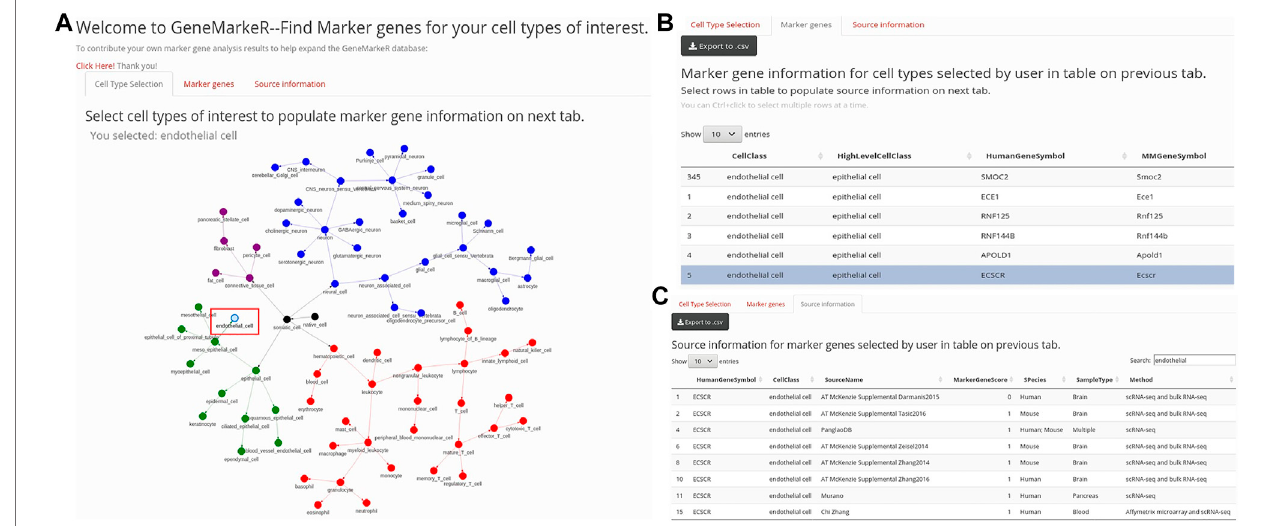
FIGURE 1 | GeneMarkeR user interface. (A) “ Cell Type Selection ” tab enables selection of cell types from a drop-down menu (not shown) and a hierarchical cell network(abbreviatednetworkshownhere).Uponselectionofcelltypes,the “ Markergenes ” tabispopulated. (B) “ Markergenes ” tabdisplaysmarkergenesandspecies speci fi cityinformationfromGeneMarker.db fi lteredtotheuser-selectedcelltypes.Uponselectionofmarkergenesofinterest,the “ Sourceinformation ” tabispopulated. (C) “ Source information ” tab displays source, sample and statistical data from CellSearcheR.db fi ltered to the user-selected marker genes. All GeneMarkeR data can be exported to CSV.